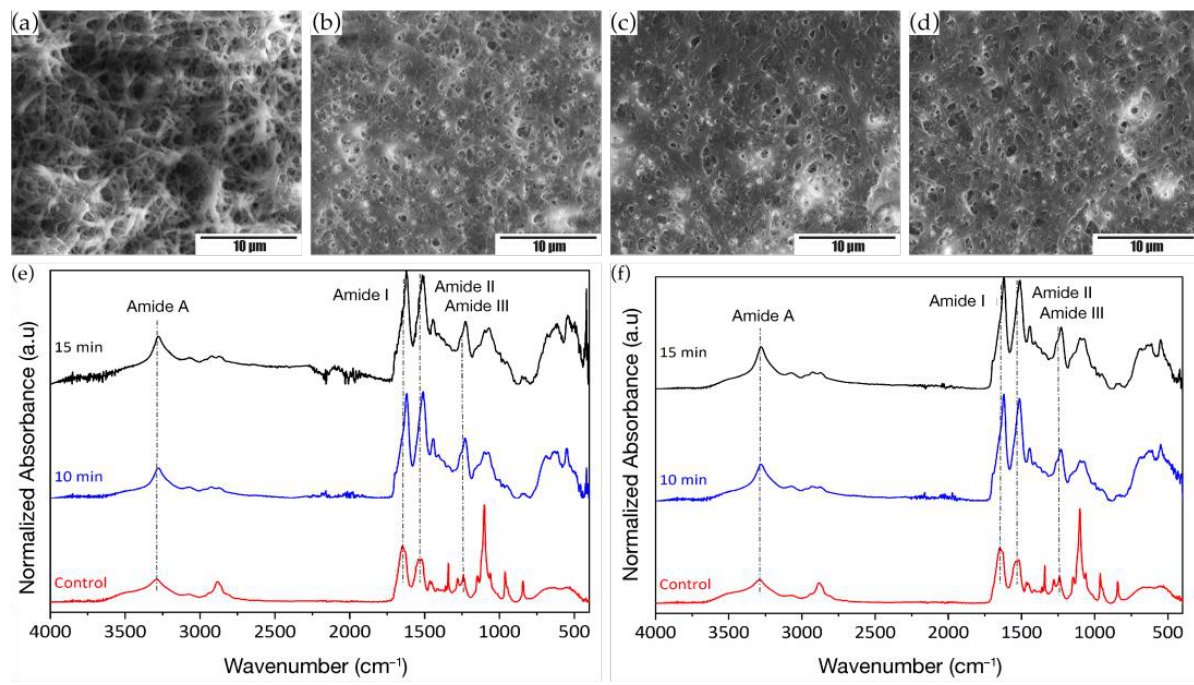
Figure 3. SEM micrographs of SF w /PEO electrospun membranes at a volumetric ratio of 50:50 treated with methanol at distances of 20 cm, for ( a ) 10 min; ( b ) 15 min. The distance of 25 cm, during ( c ) 10 min; ( d ) 15 min. Scale bar, 10 µ m. Infrared absorption spectra of electrospun SF w /PEO membranes at a volumetric ratio of 50:50 treated with methanol for 10 min and 15 min. Where ( e ) 20 cm; ( f ) 25 cm. Untreated SF w /PEO electrospun membranes were used as controls.